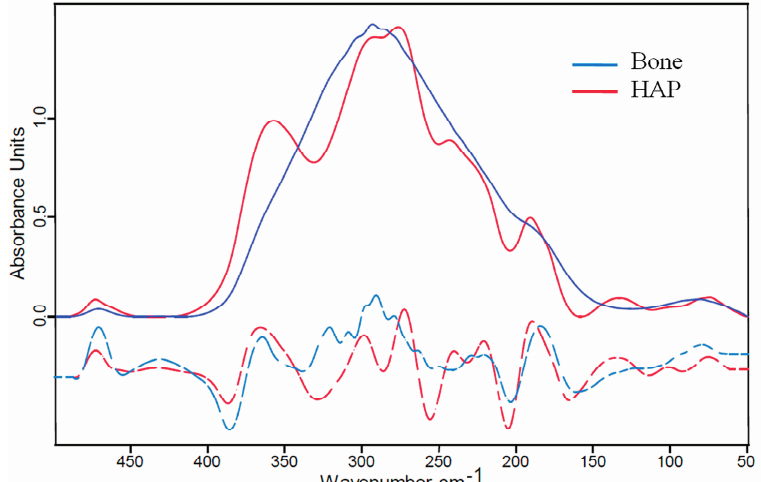
Figure 2. Far-IR spectroscopy on bone. The spectrum of a 18 µm-thick foil of fibrolamellar bovine bone ( blue line ) is shown together with the spectrum of hydroxyapatite (HAP) powder ( red line ), HAP being the mineral component of the nanocomposite bone. Both samples absorb the radiation in a very similar spectral region and, apart from peak broadening in the case of bone, show similar spectral features evidenced also through the second derivative analysis ( dashed lines